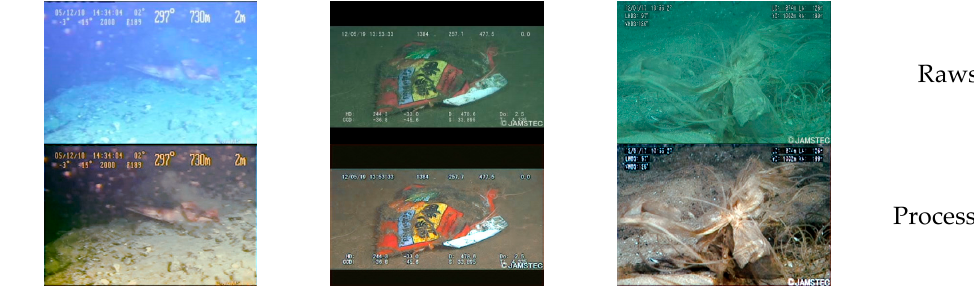
Figure 10. Enhancement on Trash_ICRA19.